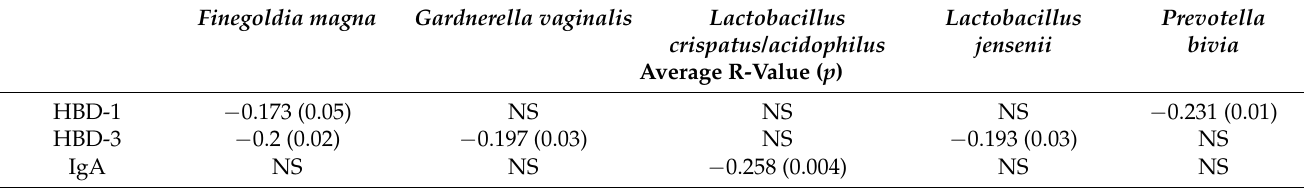
Table 11. Repeated measures correlations between normalised reads of 16 ASVs that were present in at least 40% of the participants and immune markers. The verum and placebo groups and all timepoints were joined for the analysis. Only significant results are shown. HBD, Human β -defensin; IgA, Immunoglobulin A; NS, not